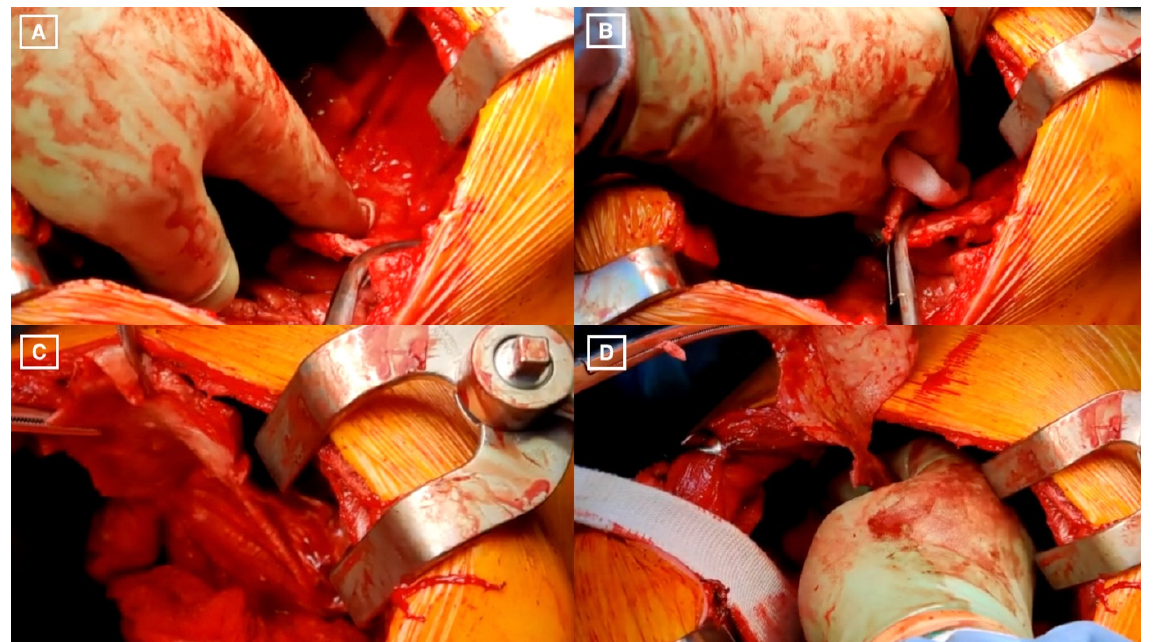
Figure 1. Diaphragm-Sparing Macroscopic Complete Resection: Operative Technique. ( A ) Separating the parietal pleura from the underlying muscle and the tendon; ( B ) Digital separation with dry gauze wrapped around the index and middle fingers; ( C ) Separated parietal pleura; ( D ) Further digital separation of the parietal pleura.